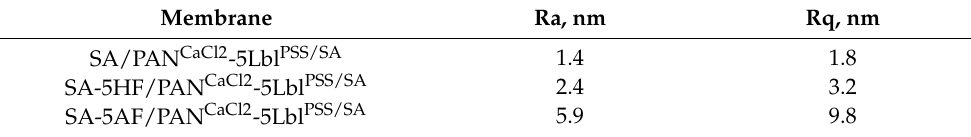
Table 5. The surface roughness parameters for the surface-modified